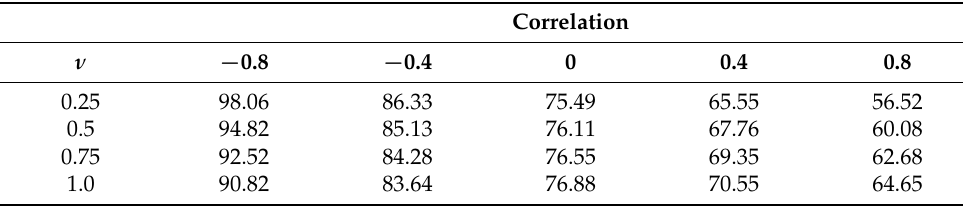
Table 3. Product of a call and a put.